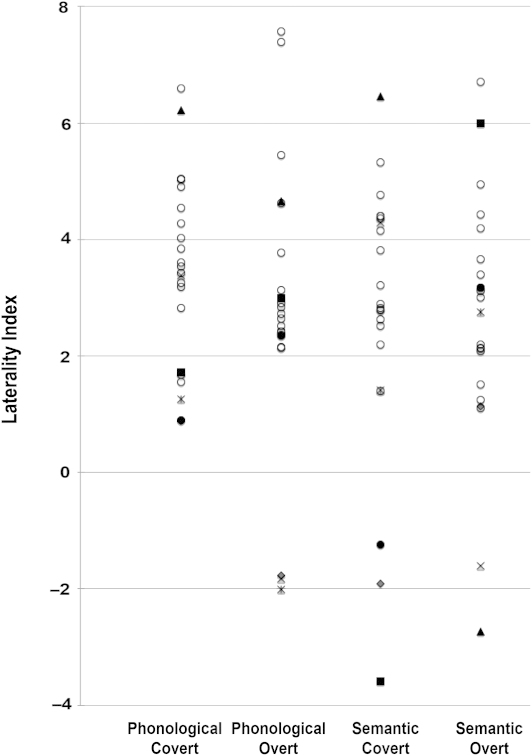
Individual LI scatterplots for each condition. The LIs for atypical individuals in any of the four conditions are shaped-coded. Each shape consistently represents each of these six participants across conditions.